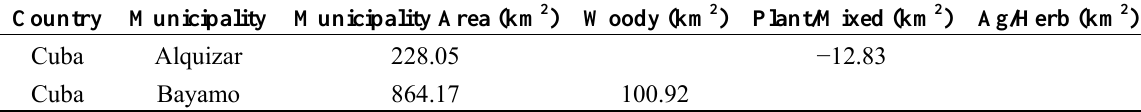
Table S1. Municipalities which underwent significant change ( p ≤ 0.05) by country, and area (km 2 ) of land change for each